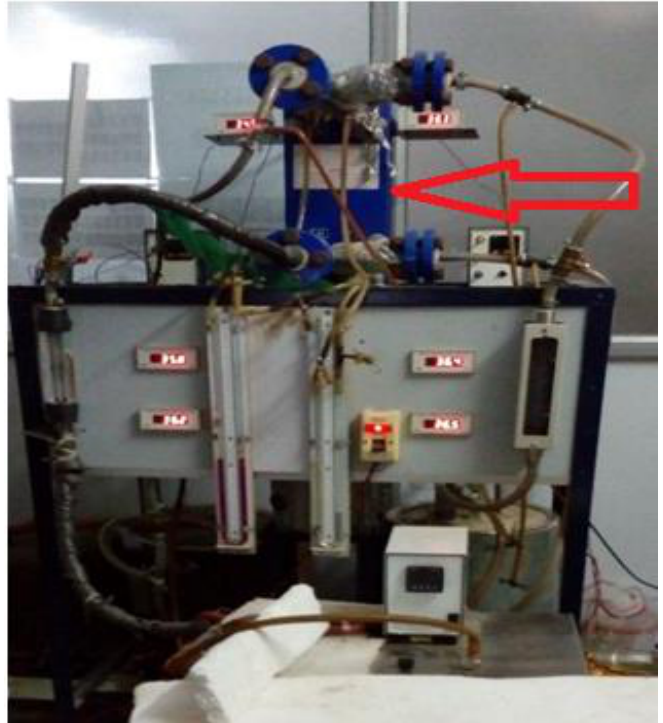
Figure 5. Experimental setup showing PHE with a red arrow.